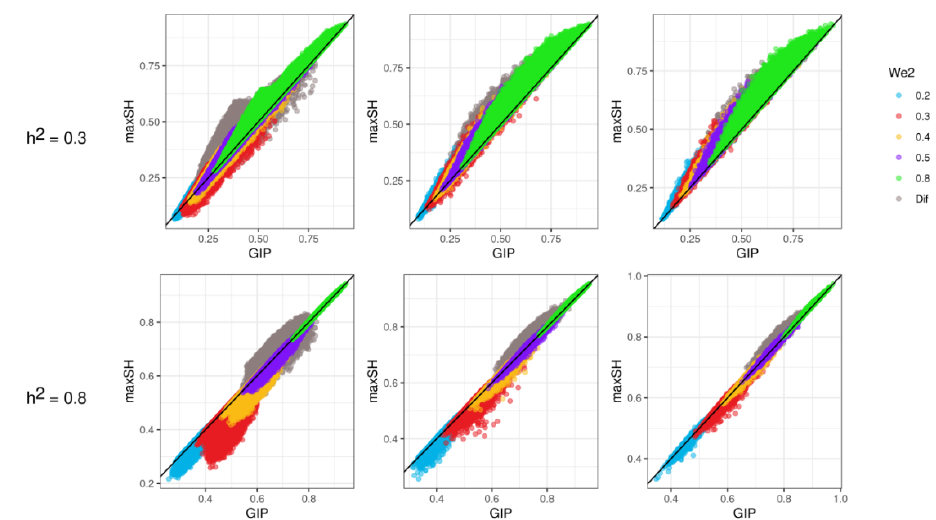
Figure 3. The plot of the shared heritability of SGIT (the maxSH method) versus the shared heritability of GIP1 (the GIP method). For different h 2 and different number of traits (Ntr) for s = 0.3.